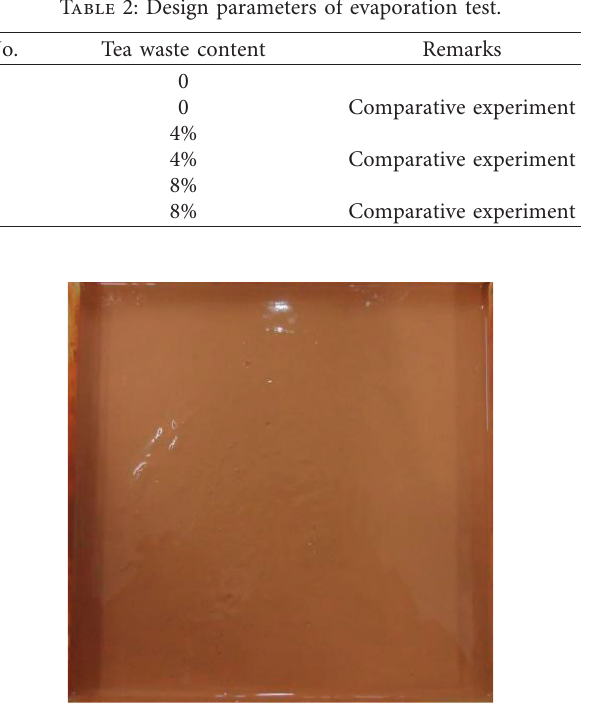
Figure 1: Saturated mud